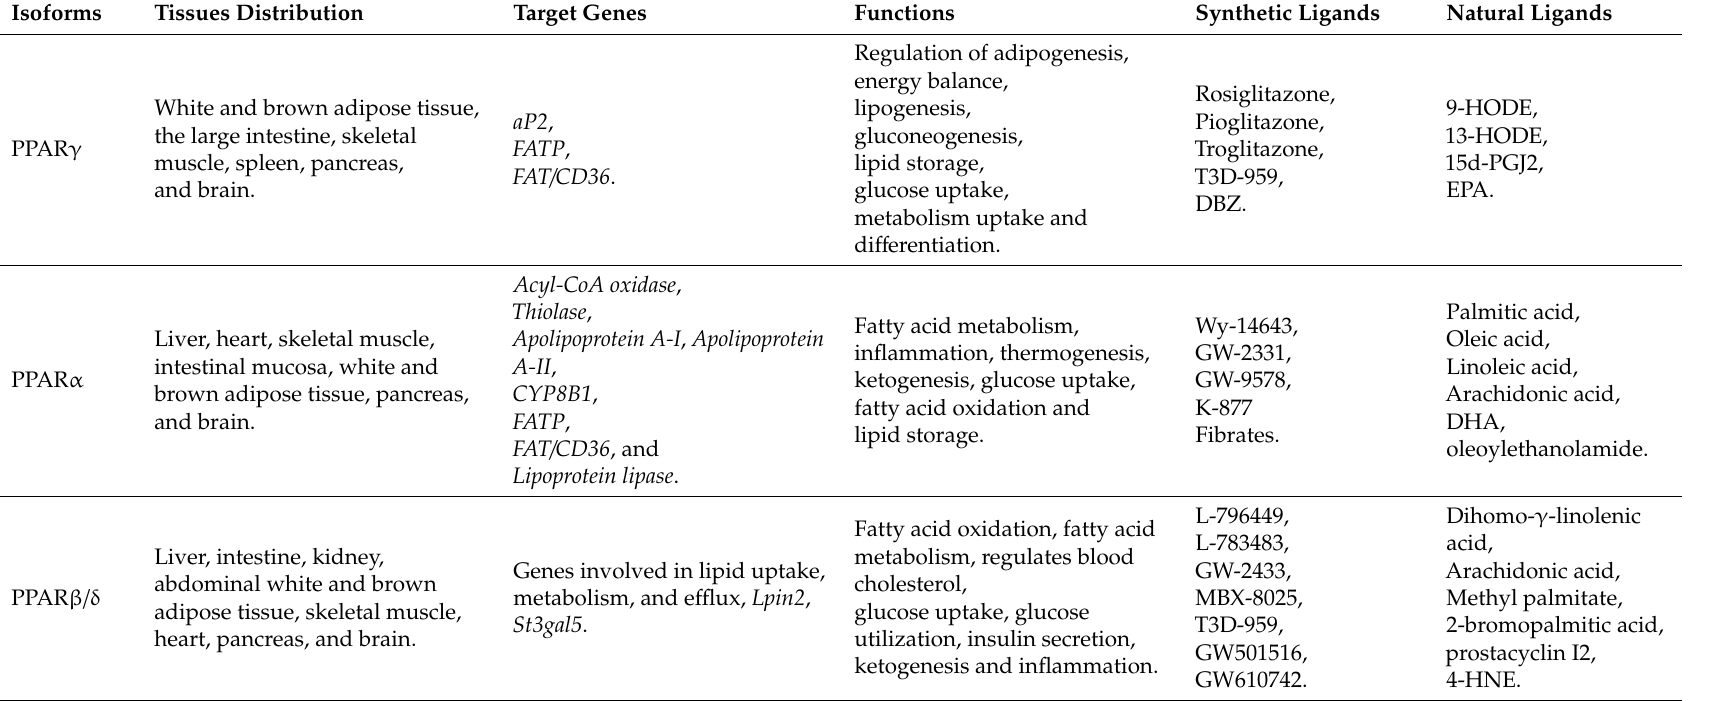
Table 1. PPARs tissue distribution and biological